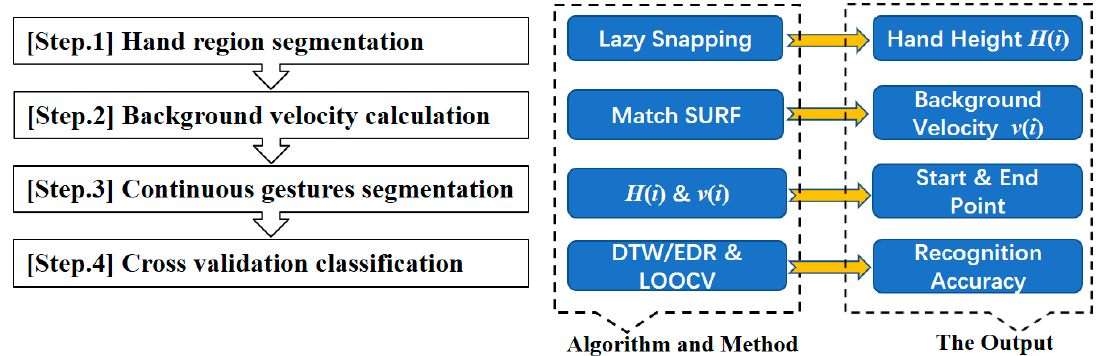
Figure 4. The algorithm flow diagram of the continuous HMT gesture recognition.